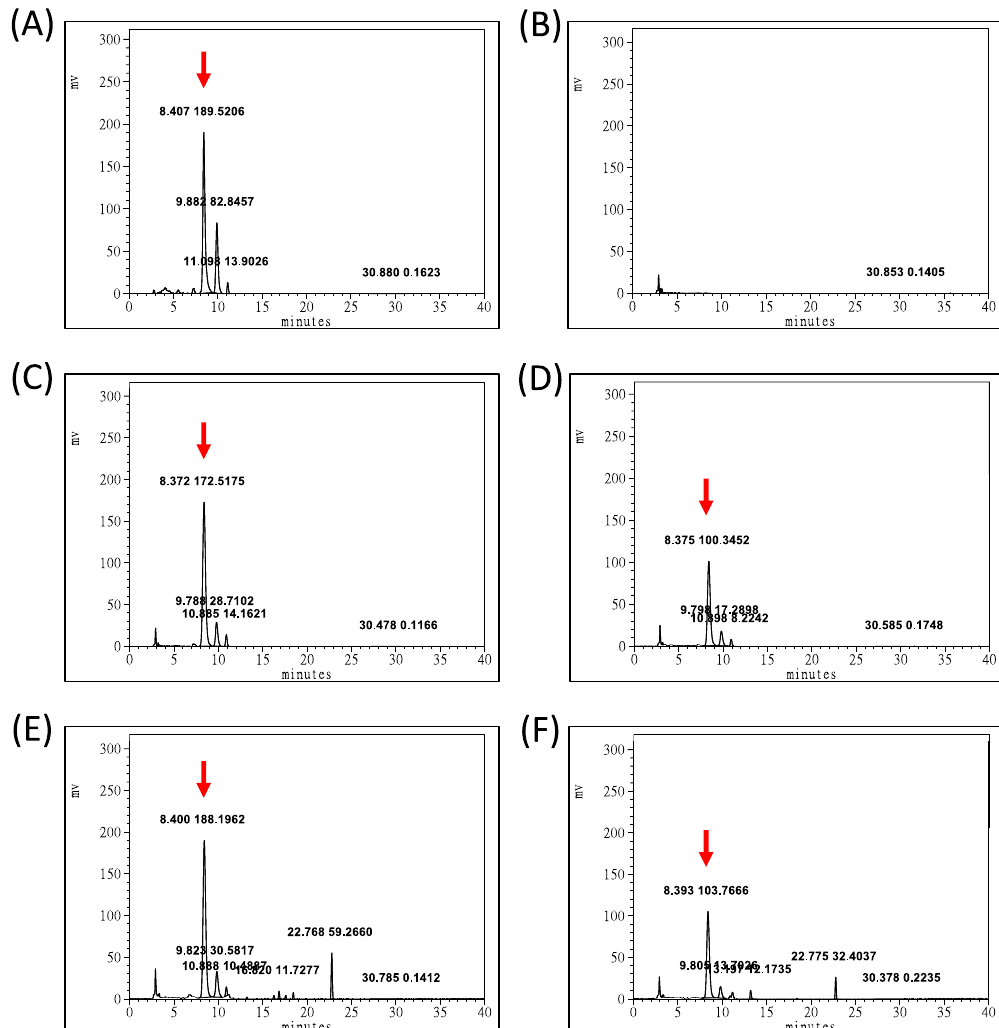
Figure 1. The HPLC profiles of experimental feeds. ( A ) AST reference standard, ( B ) The basal feed, ( C ) Feed with CP, ( D ) Feed with LP, ( E ) Feed with TE, ( F ) Feed with TB. Red arrow indicates the AST